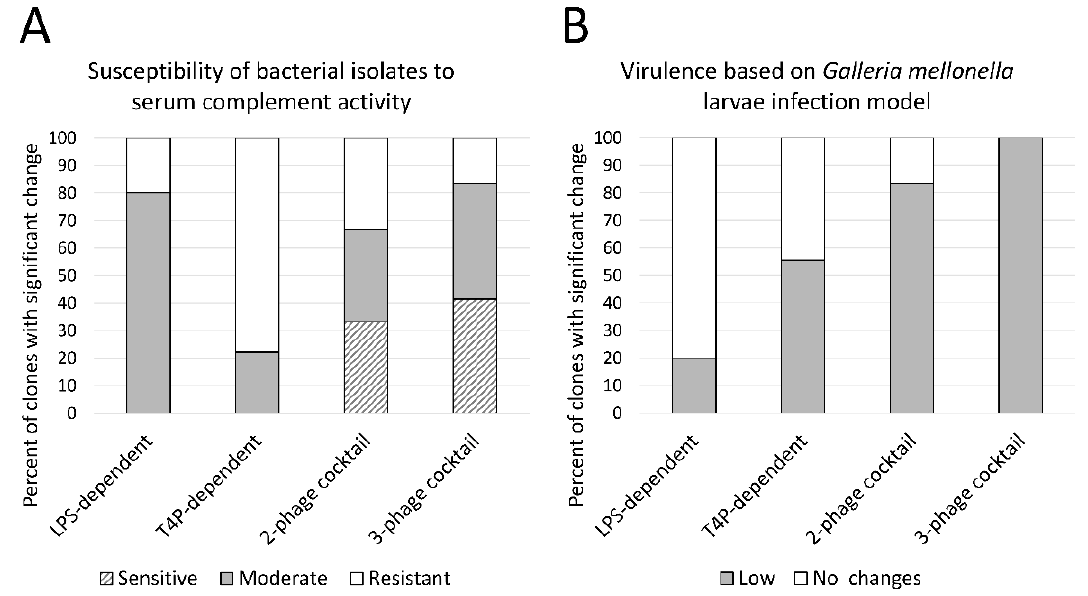
Figure 5. Changes in the virulence in emerging phage-resistant PAO1 clones versus the wild-type PAO1 sessile population measured as: ( A ) susceptibility to serum complement; white bars—resistance to serum complement (1 log increase in the final CFU/mL); light grey bars—moderate sensitivity (0–1 log decrease in the final CFU/mL); striped bars—sensitivity (>1 log decrease in the final CFU/mL); ( B ) survival rate in the G. mellonella infection model; white bars—no changes; grey bars—a significant decrease ( p < 0.05). Untreated sessile PAO1 were used as a control. The statistical analysis for the G. mellonella model was conducted using the log-rank Mantel-Cox test.